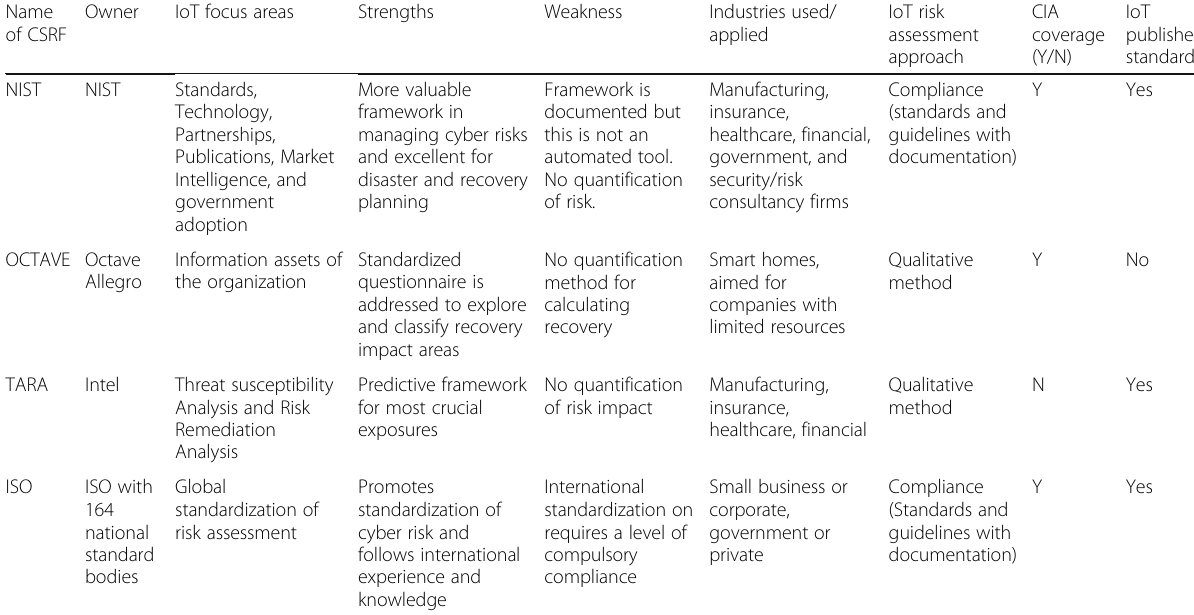
Table 1 Comparison of CSRF Name of CSRF